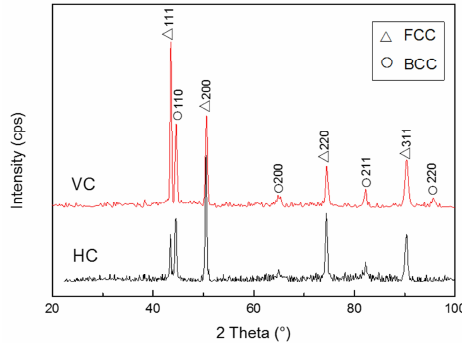
Figure 11. XRD patterns of the cross sections of the Al 0.5 CoCrFeNi HEAs.